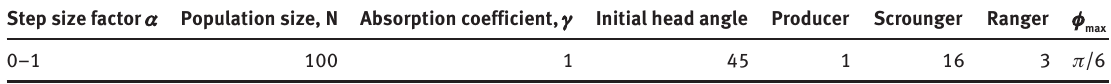
Table 5: Parameters of the HFGSO Algorithm.